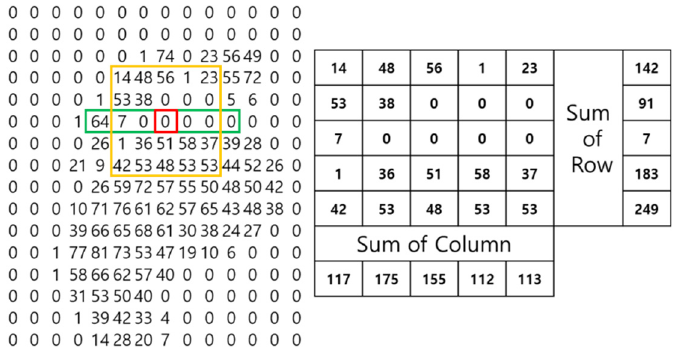
Figure 4. Characteristic pressure features of the arch.